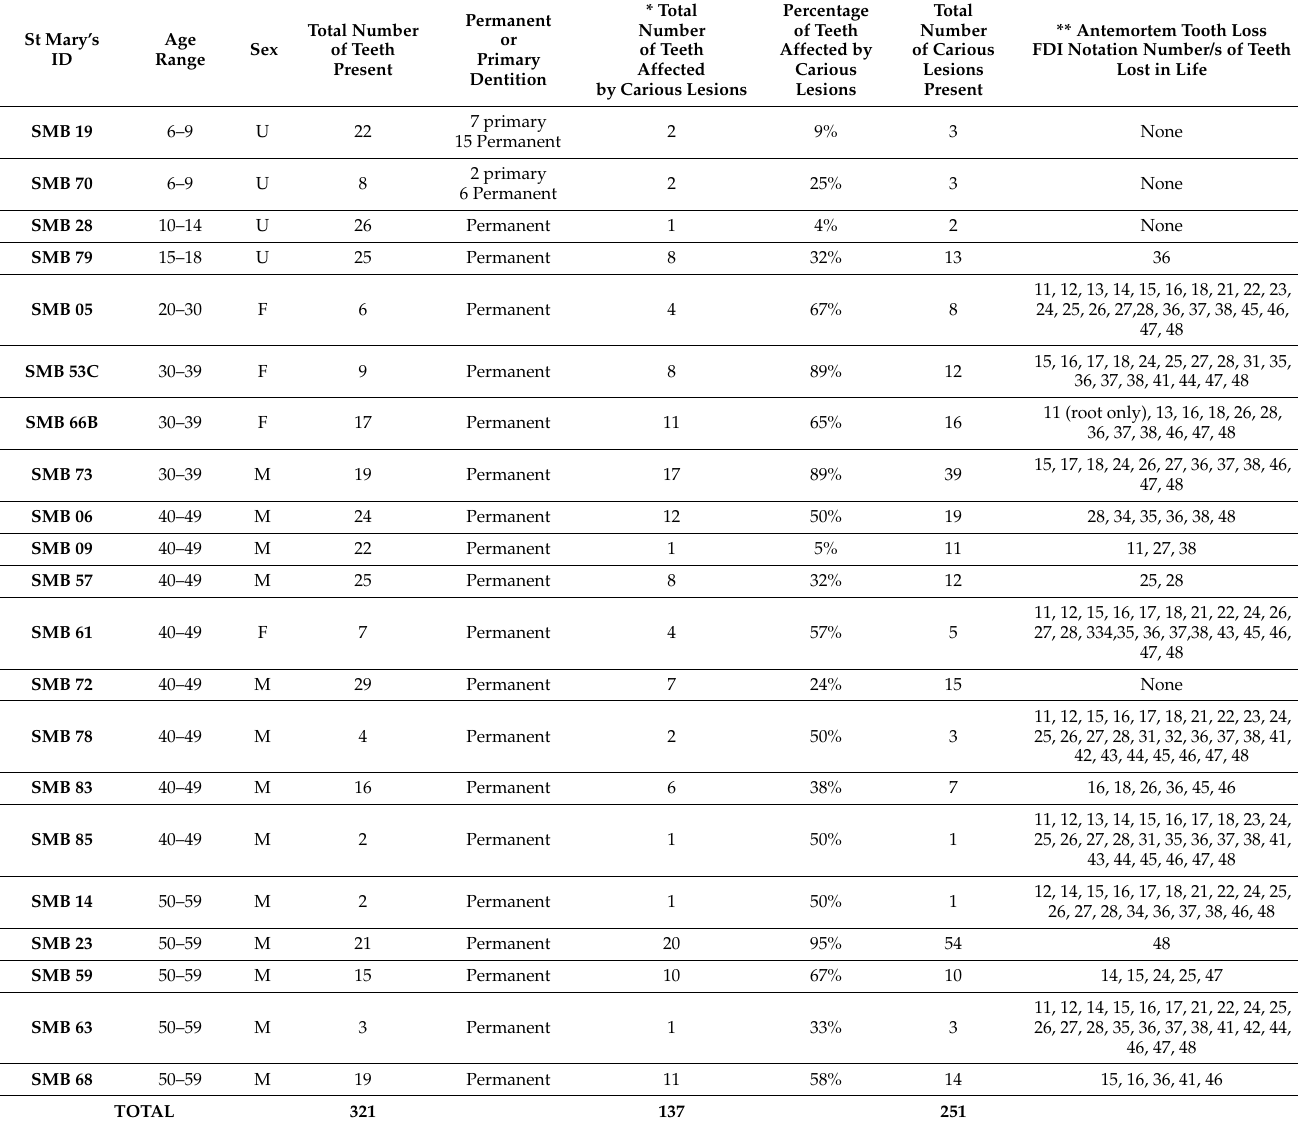
Table 3. Number and percentage of carious lesions identified for individuals from the St Mary’s sample, with identification of teeth lost in life